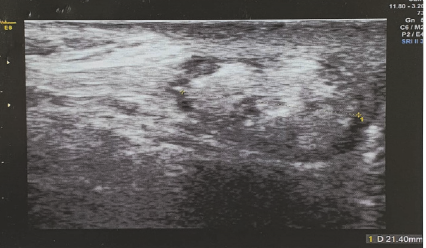
Figure 1: US demonstrating a solid 21 mm mass within the right epididymis.